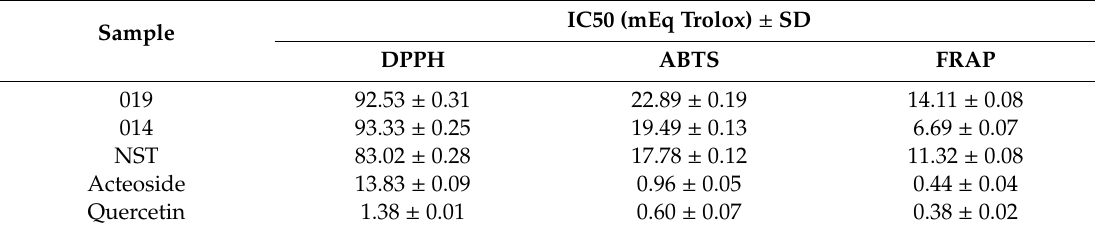
Table 3. Antioxidant activity (IC50) of the spagyric tinctures 019 and 014 and the NST of H. procumbens .